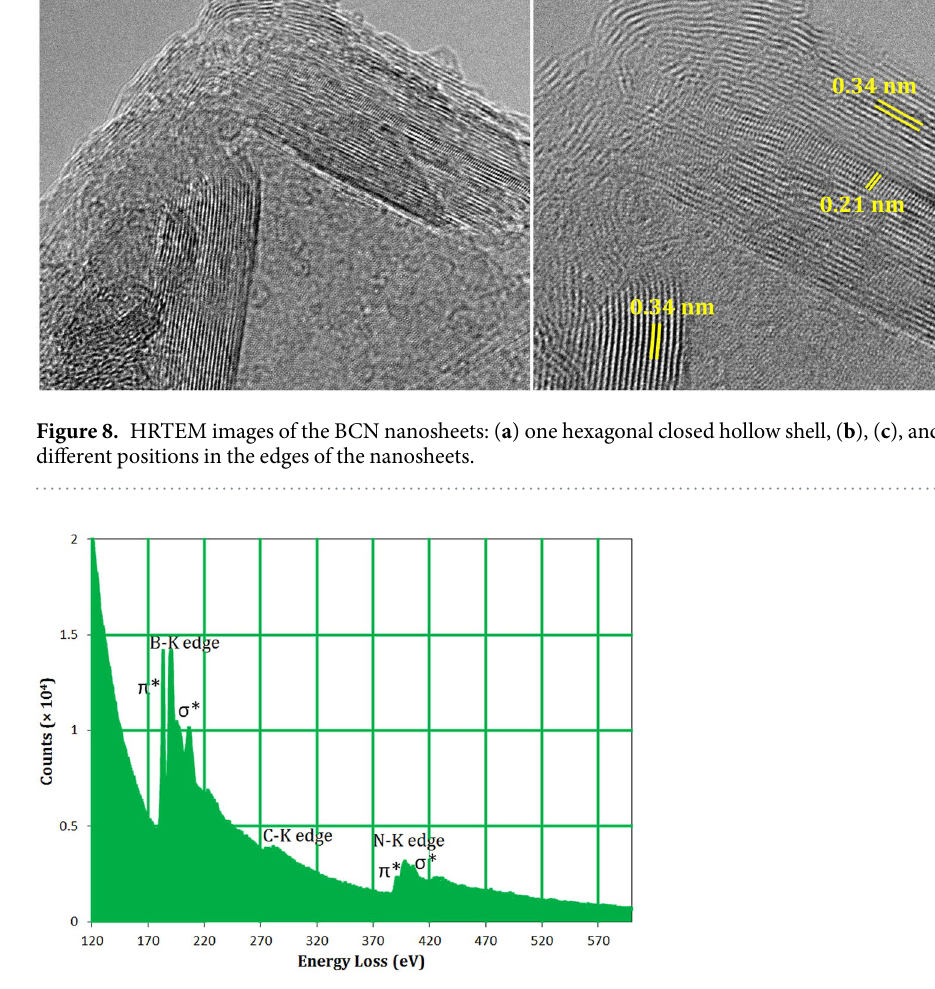
Figure 9. EELS spectrum of the BCN